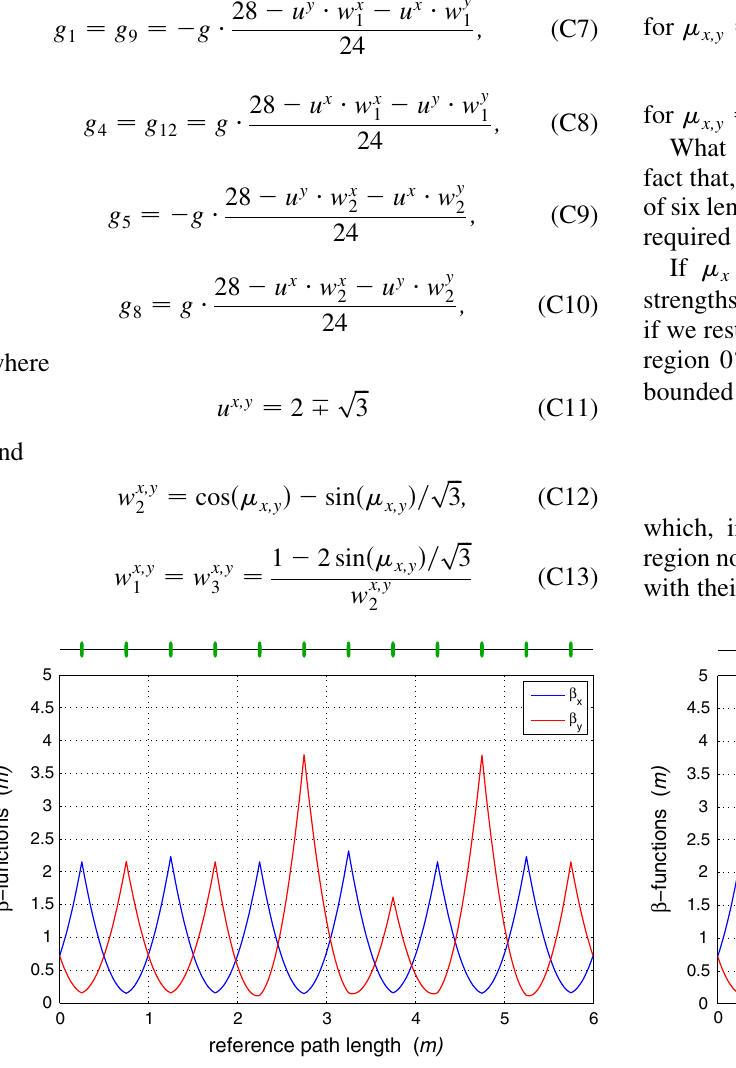
FIG. 2. Betatron functions along the phase advance scan beam ¼ 0 (cid:8) , (cid:8) ¼ 60 (cid:8) . line for (cid:8) x y